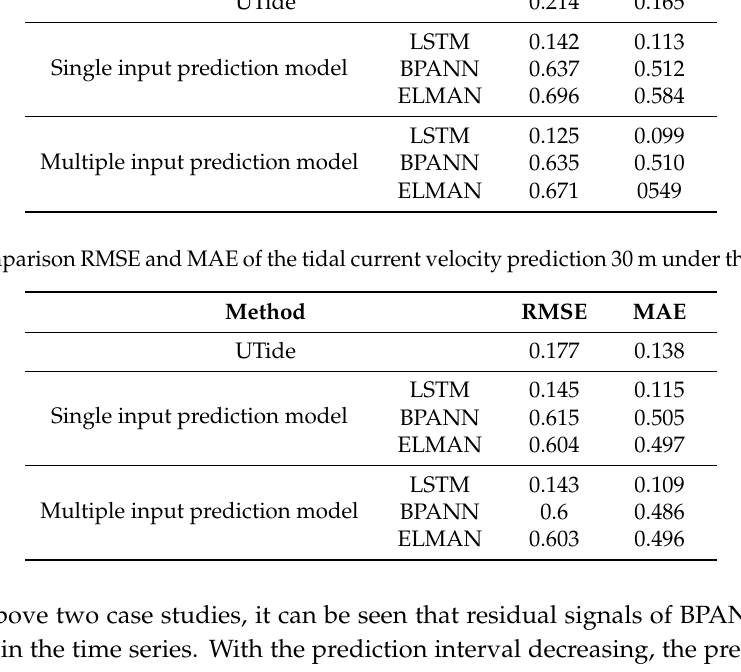
Figure 19. Residual signals of the proposed method by using three machine learning algorithms and UTide (30 m under sea surface). ( a ) Residual signals by using BP and UTide, ( b ) Residual signals by using ELMAN and UTide, ( c ) Residual signals by using LSTM and UTide.